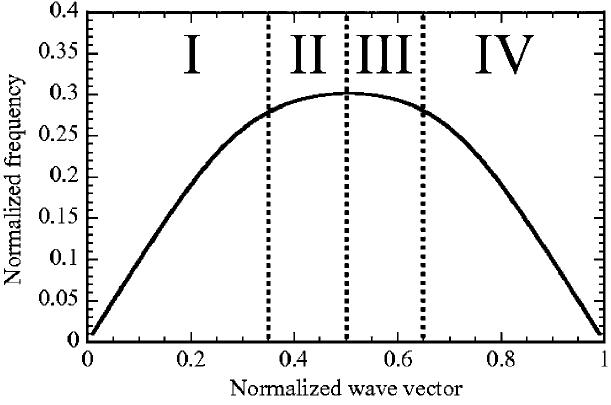
FIG. 4. Division of operating regions by transverse